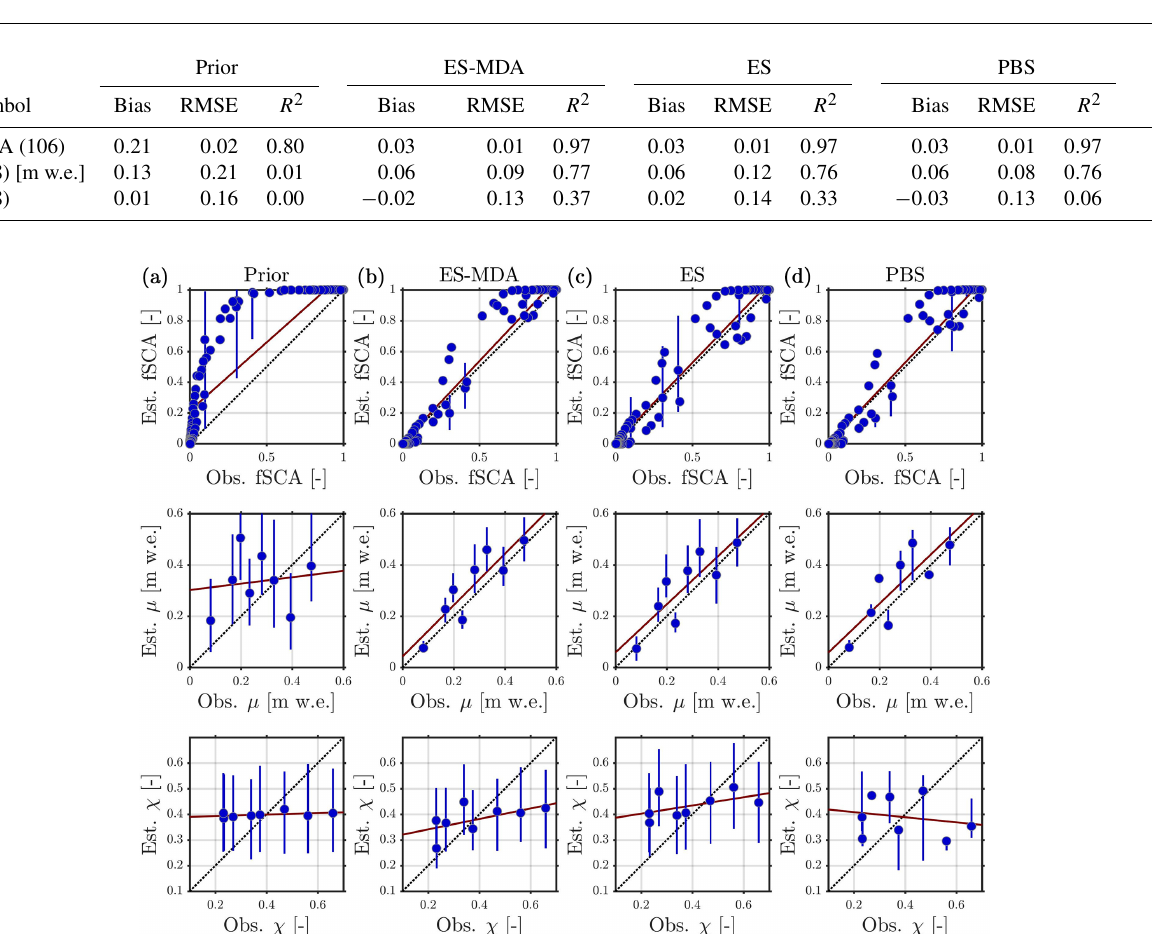
Table 5. Summary of evaluation metrics – i.e., bias, RMSE and square correlation coefficient ( R 2 ) – for the fSCA, peak SWE ( µ ) and peak subgrid coefficient of variation ( χ ). These metrics are based on comparisons to all the field measurements presented in Sect. 2.2 with the number of observations for the comparisons in brackets next to the corresponding symbols. All the metrics are averaged over 10 2 independent runs, each with 100 ensemble members. The ES-MDA was run with N a = 4 assimilation cycles.